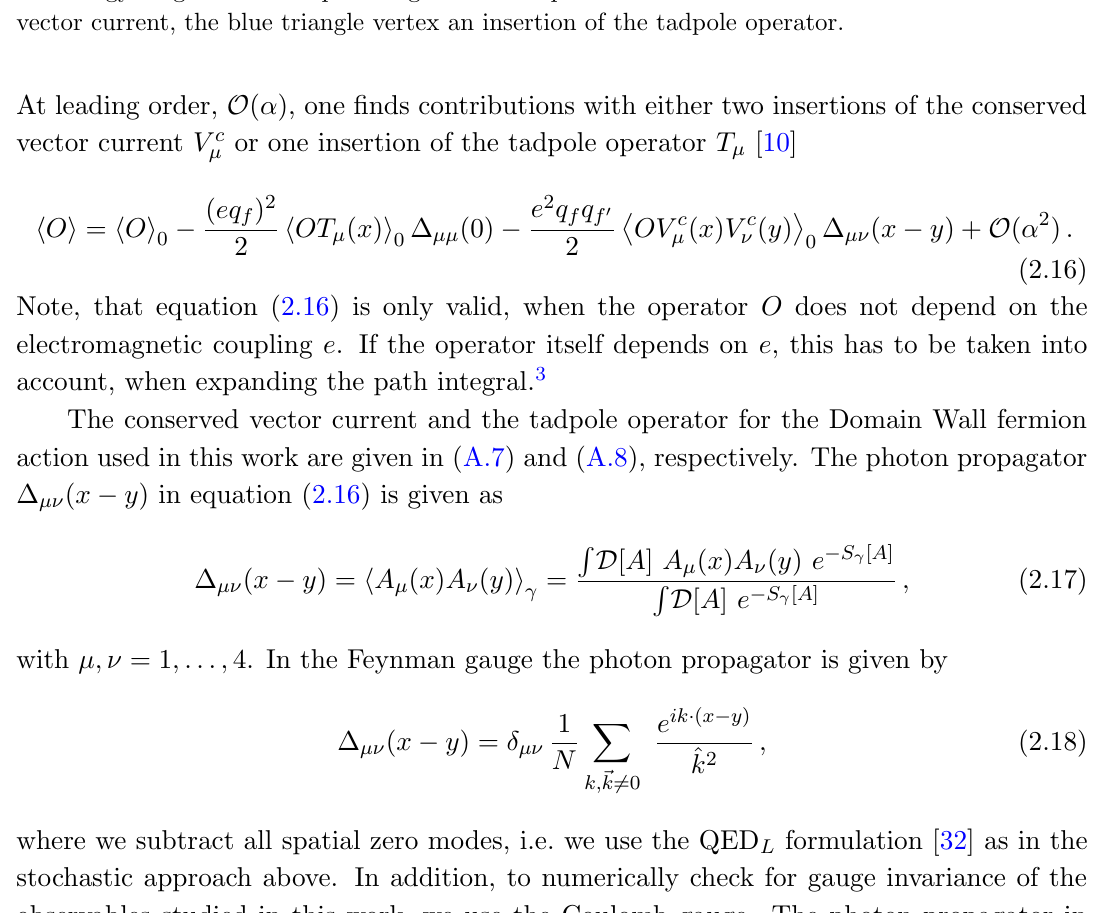
Figure 1 . The three quark-connected diagrams that determine the leading order QED correction to mesonic two-point functions. The diagrams are from left to right: photon exchange diagram, quark self-energy diagram and tadpole diagram. Red squared vertices denote insertions of the conserved vector current, the blue triangle vertex an insertion of the tadpole